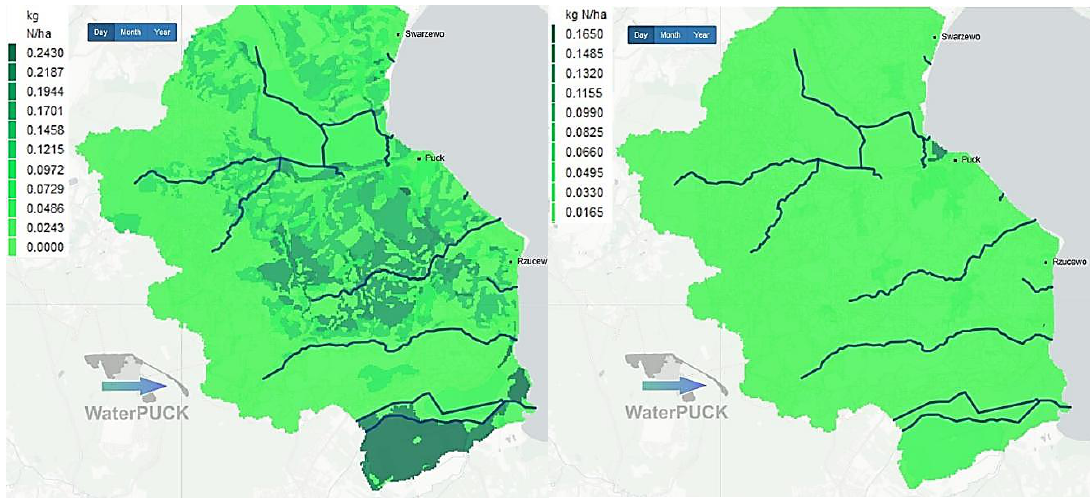
Figure 7. Daily sum of nitrogen in surface runoff, high intensity (on the left) and low (on the right) rain scenario, July 28, 2018.